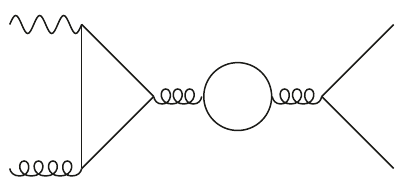
Figure 3 . Example of self-energy corrections to the pure-singlet class of diagrams. Both N f massless and N h massive quarks are allowed to circulate in all fermion